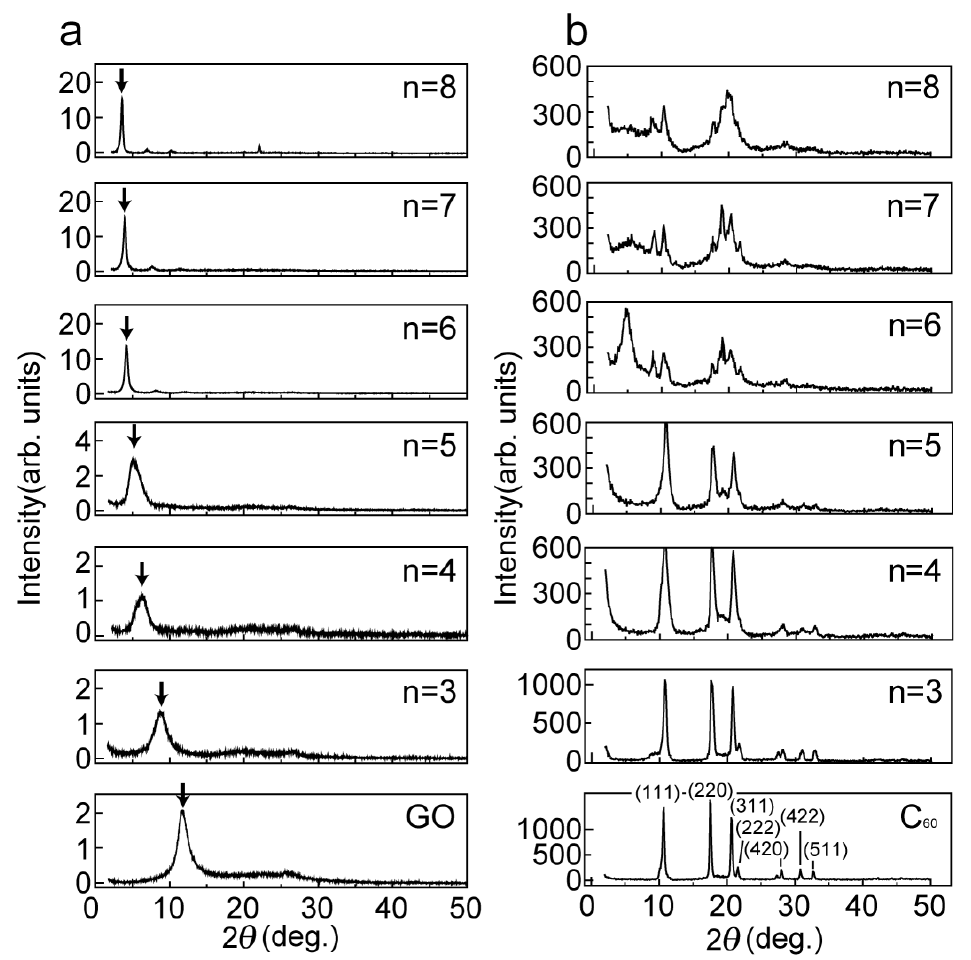
Figure 1. XRD intensity from as-prepared samples. ( a ) XRD intensity from graphite oxide (GO) and alkylamine-intercalated graphite oxides (GO-amine) with different chain lengths (C H NH ) (n = 3–8). The peaks of GO and GO-amine are indicated by the arrows in the n 2n+1 2 figure; ( b ) XRD intensity from GO-amine with different chain lengths in C (n =